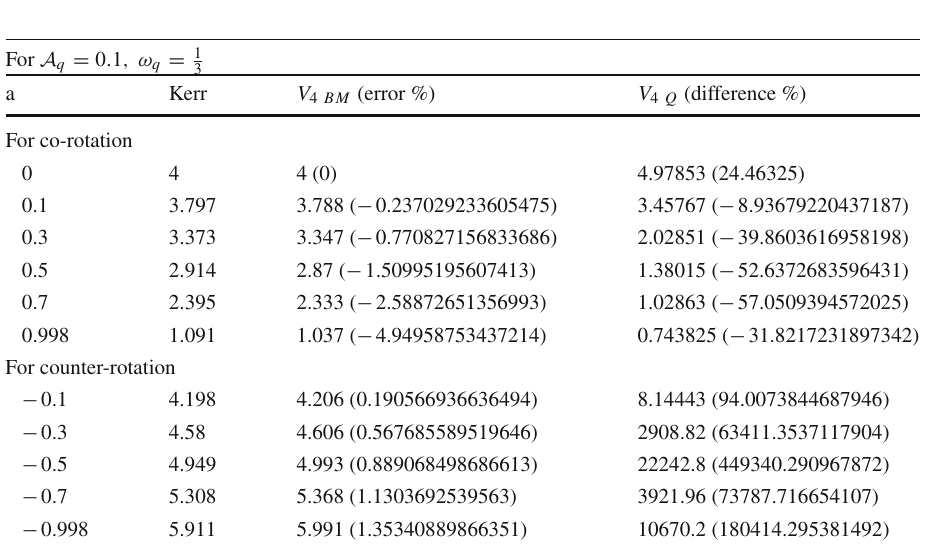
For A q = 0 . 1 , ω q = 1